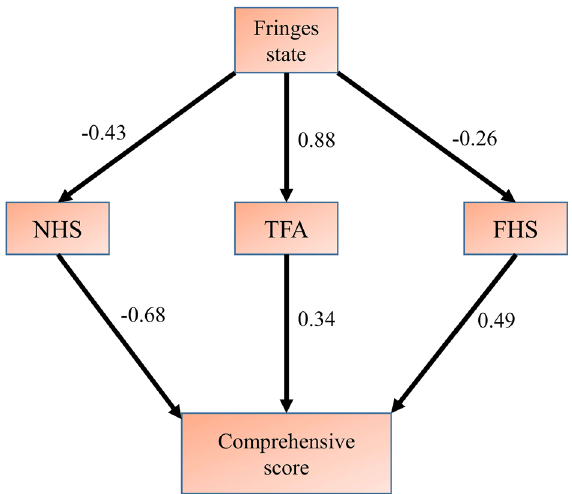
Figure 6. Path analysis diagram of sand-burying of Phrynocephalus mystaceus . Note: This path model examines how sand-burying is affected by the use of the fringe on the sand substrates. Numbers next to the path represent the relative contribution of the different fringe states during sand burying.